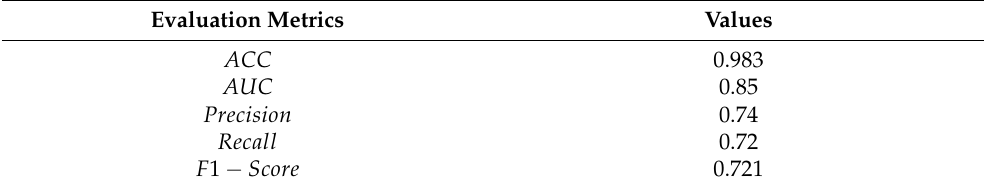
Table 8. The results of evaluation metric values obtained with application of the best symbolic expressions ( y 21 , y 22 , y 23 , and y 24 ) in multiclass on the original